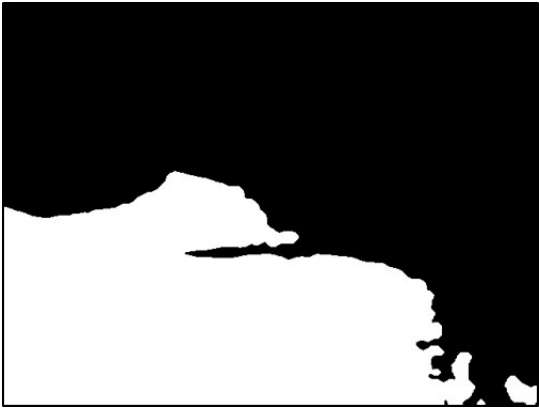
Figure 21. Result of subtracting the image before and after filling .